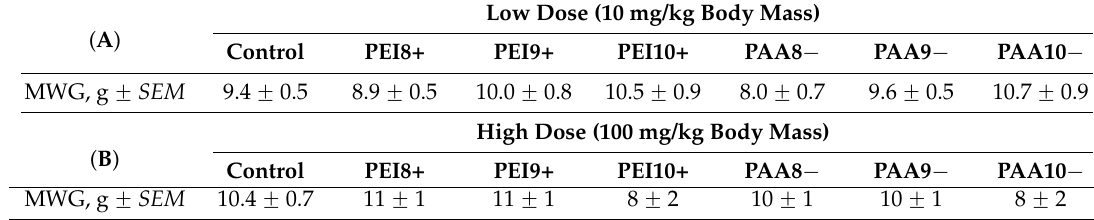
Table 2. Maternal weight gain (MWG) in g ˘ the standard error of the mean ( SEM ) during gestation of mice treated with 10 mg/kg ( A ) or 100 mg/kg ( B ) iron oxide NPs on various days of gestation (GD 8, 9, or 10). MWG was determined by subtracting the initial body mass of the dams on GD 0 from the body mass of the dams on the day of sacrifice (GD 17) minus the gravid uteri. No significant differences were observed between treatment groups and the